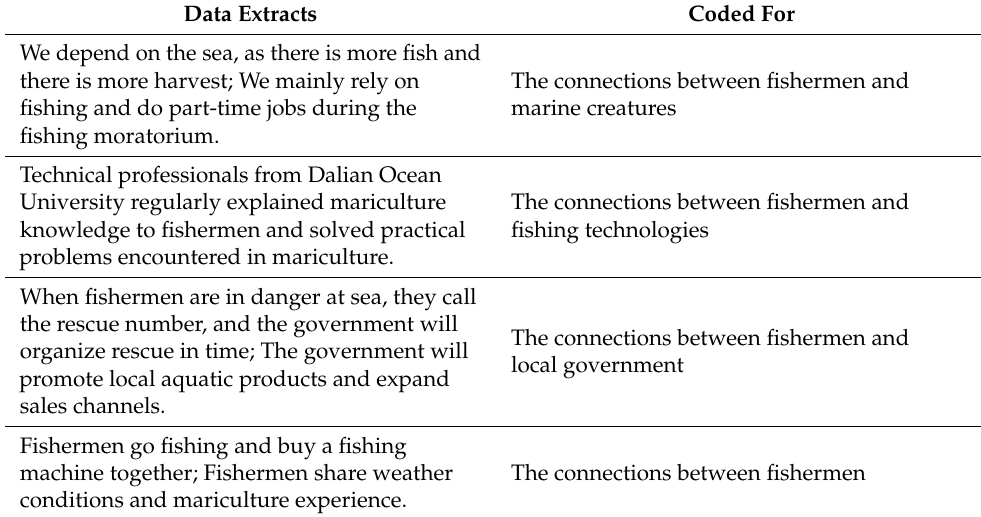
Table 3. Open coding of data